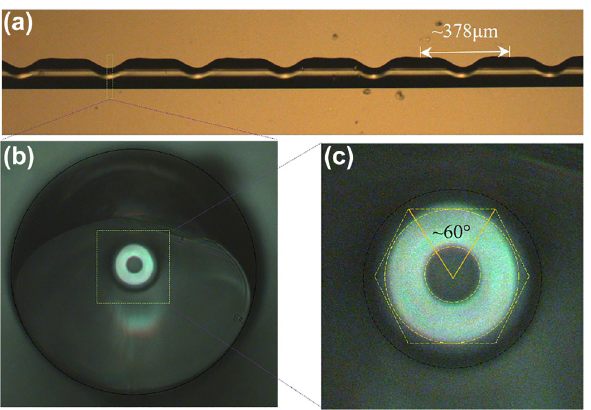
Figure 6: The experimental results of MFs. (a) The side view, (b) end face and (c) mode evolution of three